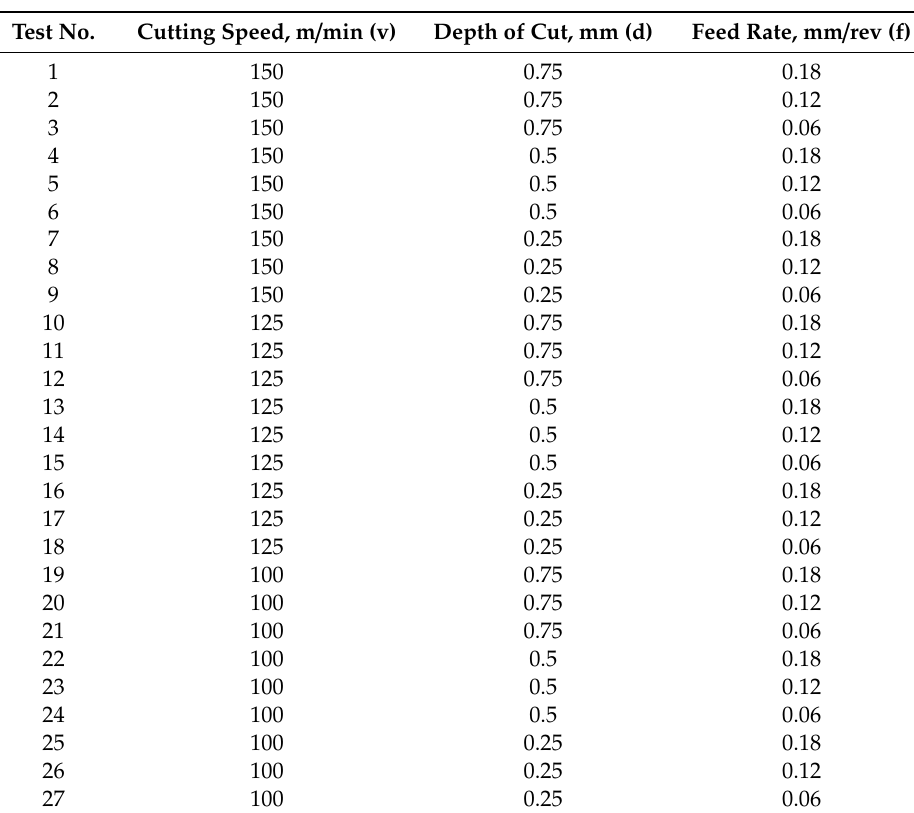
Table 3. L27 orthogonal array for design of